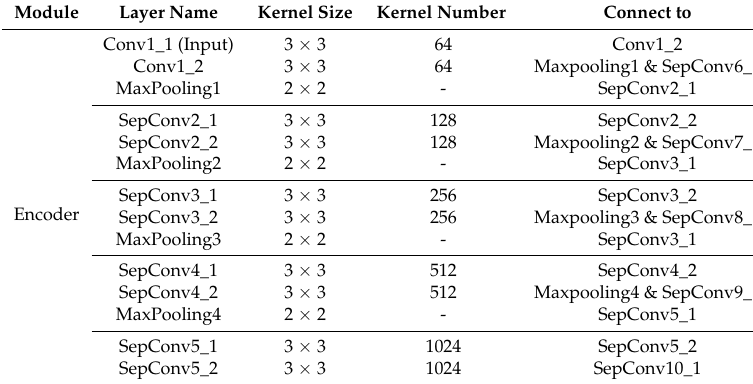
Table 1. Complete network structure of UPS-Net. Conv, sepconv and FC refer to convolution, depthwise separable convolution, fully connect,